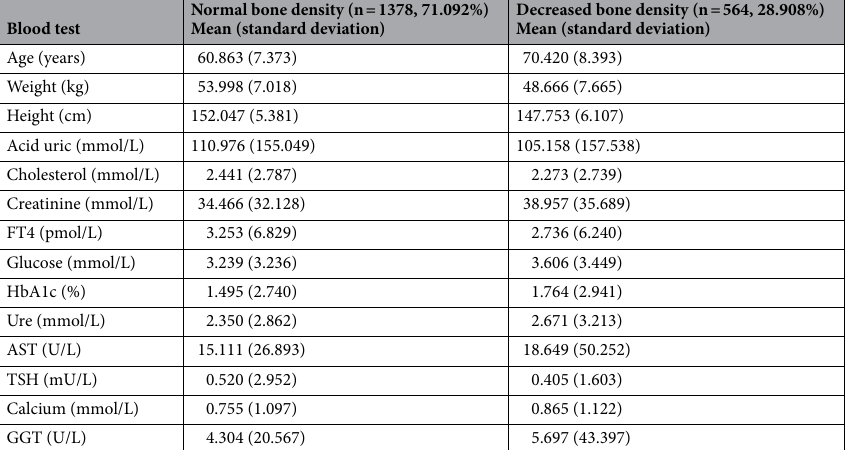
Table 4. The statistical distribution of the data in the first scenario.